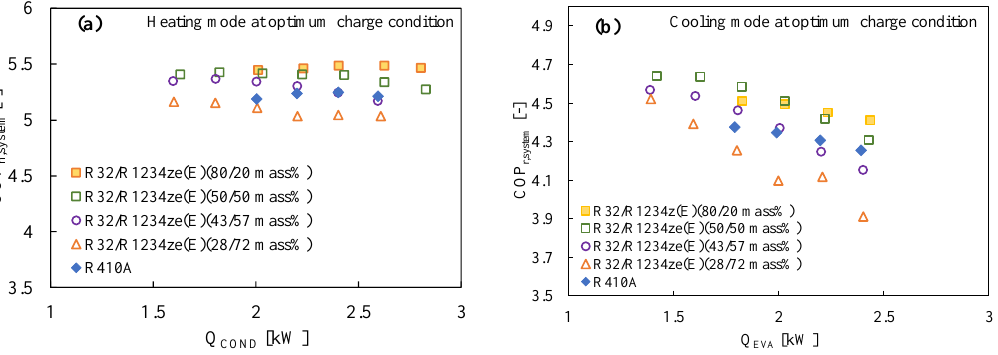
Figure 5. Variation of the COP of the R32/R1234ze(E) mixtures with the heat transfer rate in the condenser and the evaporator in a drop-in experiment at the optimum charged condition in ( a ) the heating mode and ( b ) the cooling mode [76].